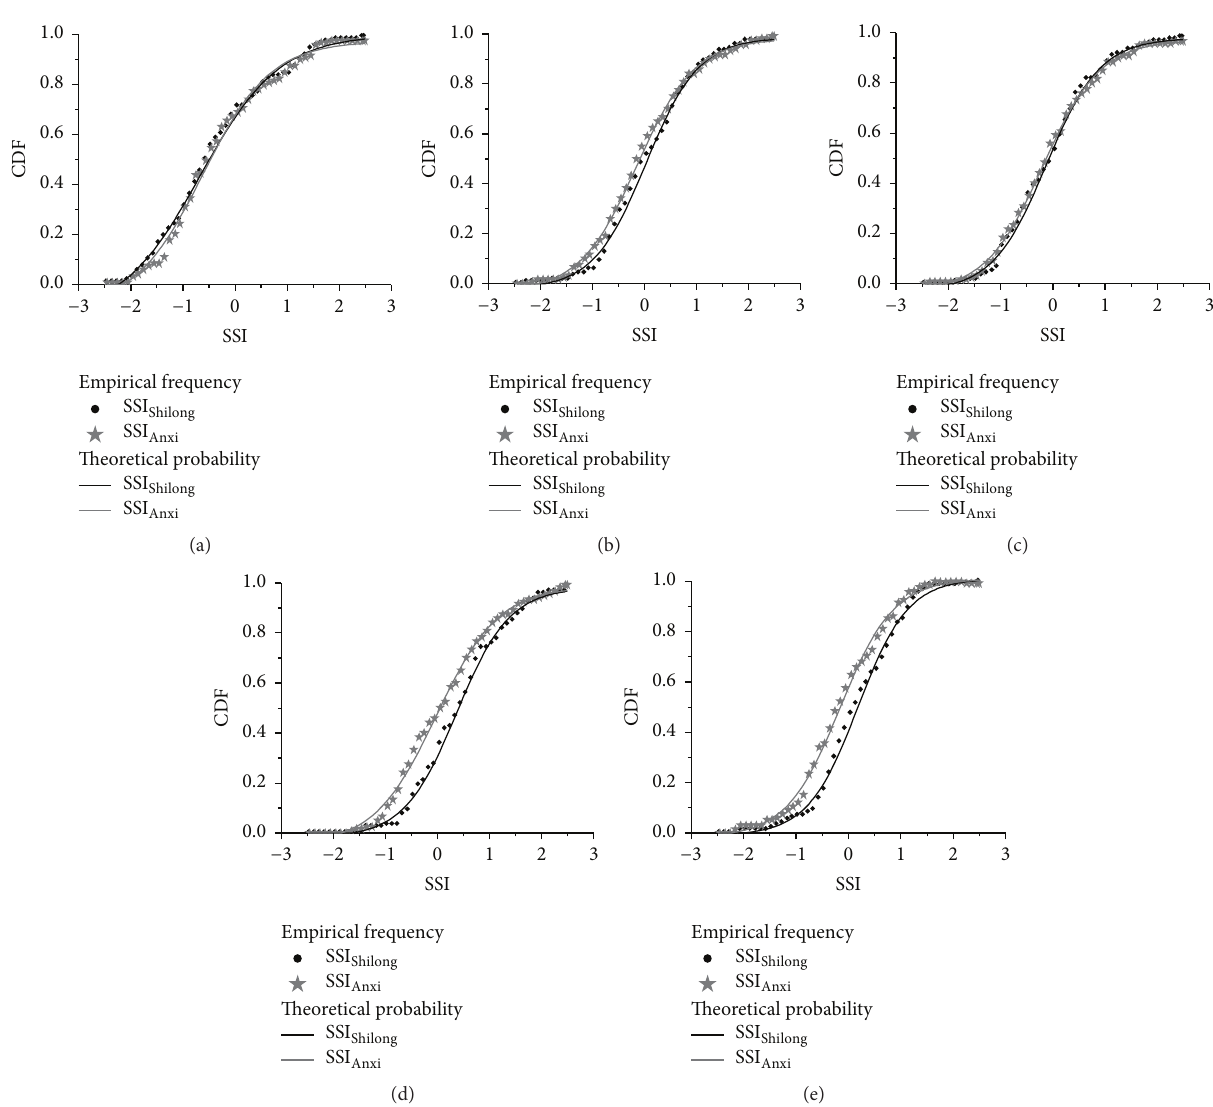
Figure 2: Comparison of cumulative distribution frequency of SSI in different decades: (a) 1960–1969, (b) 1970–1979, (c) 1980–1989,